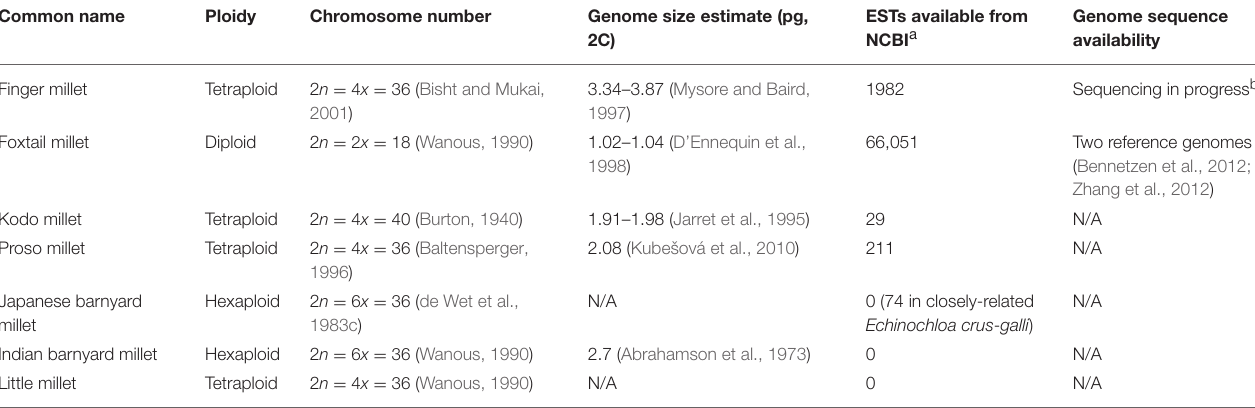
TABLE 3 | Small millet genomic resources and